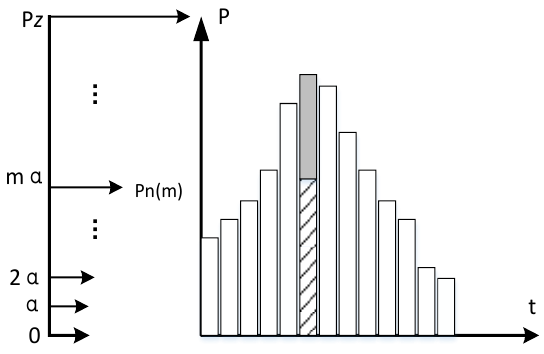
Figure 2. Schematic diagram of sequential stochastic production simulation.